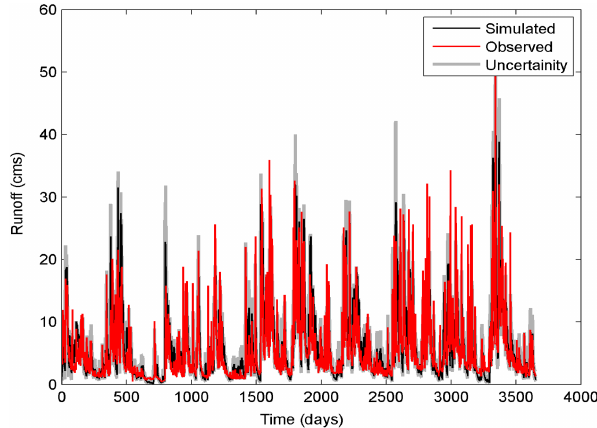
Fig. 2. Top: input precipitation; middle: temperature; and bottom: simulated ensemble streamflow (simulated runoff – solid black line; observed runoff – solid red line; uncertainty space or ensemble sim- ulation – gray